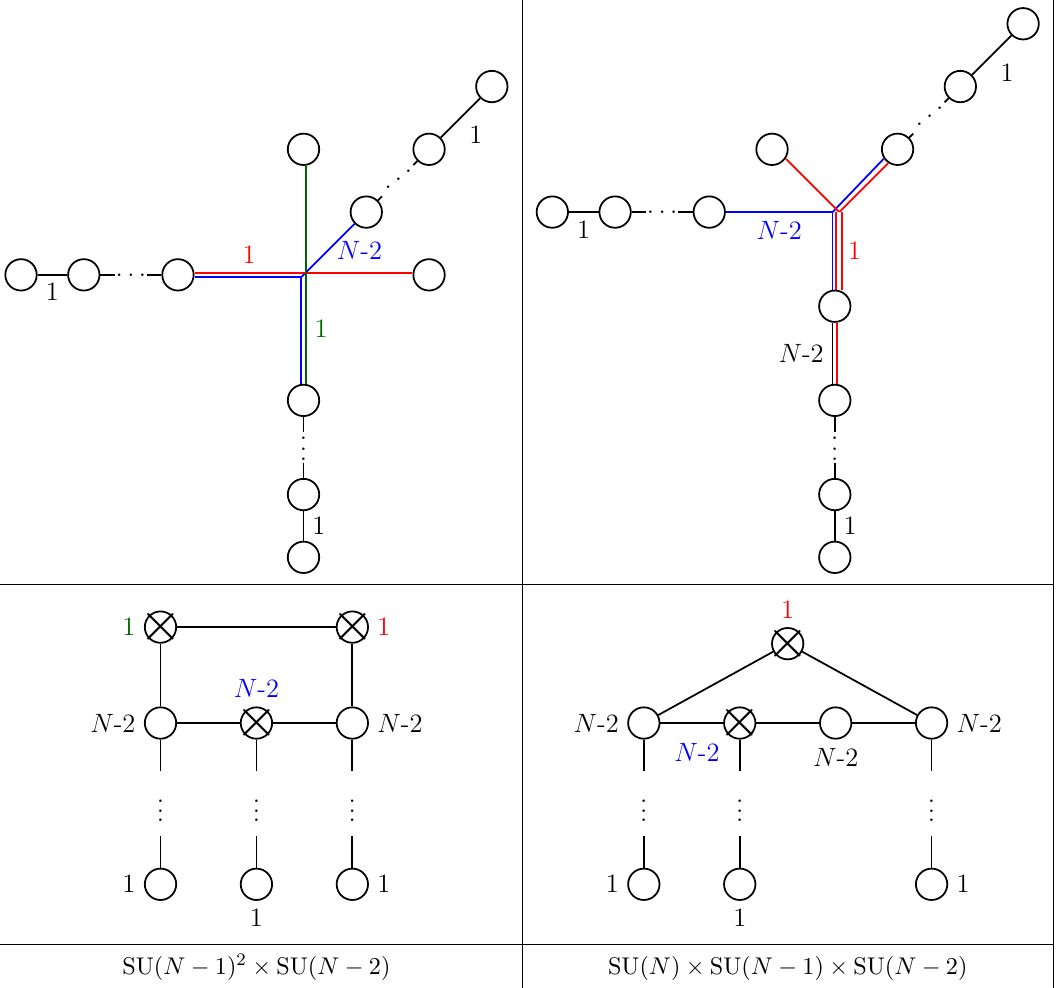
Table 2 . Brane webs and magnetic quivers for second descendants of T N with corresponding (cid:13)avor